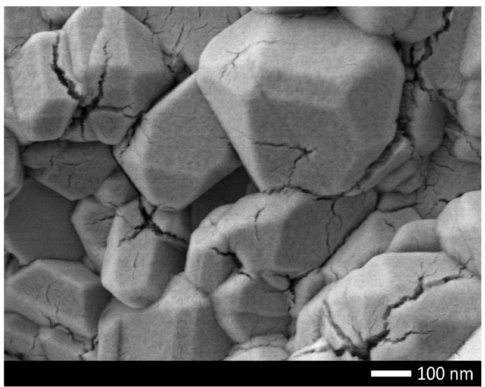
Figure 7. An example of the surface morphology of Li 2 TiO 3 ceramics after 500 h of testing at a temperature of 700